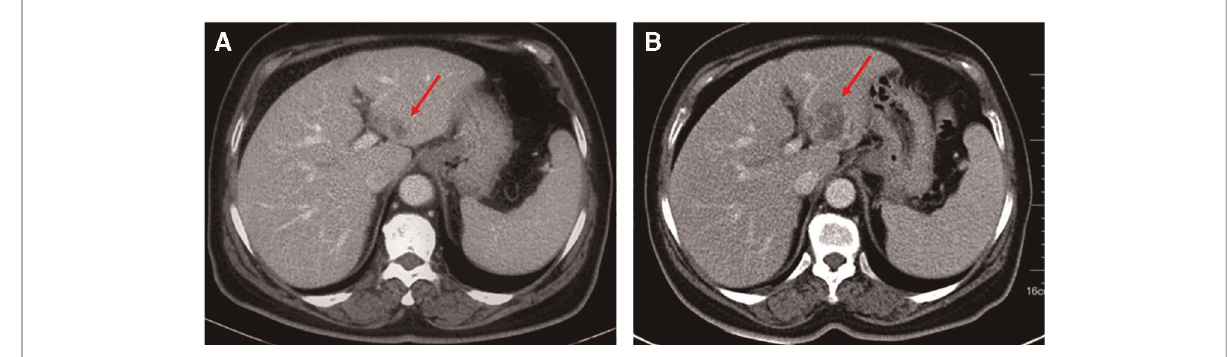
FIGURE 2 Ct examination: ( A ) April 1, 2020. ( B ) June 17, 2020. The mass of the left liver was more advanced than before.